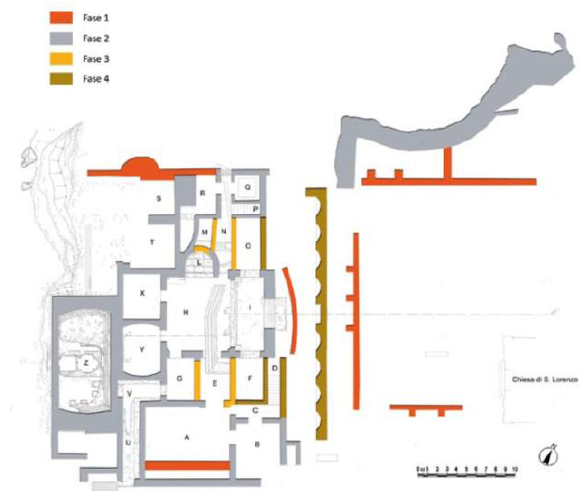
Figure 2. The thermal area of the otium sub-urban villa in the Massaciuccoli archaeological park (North-Western Tuscany, Italy), part of a system of banqueting and resting